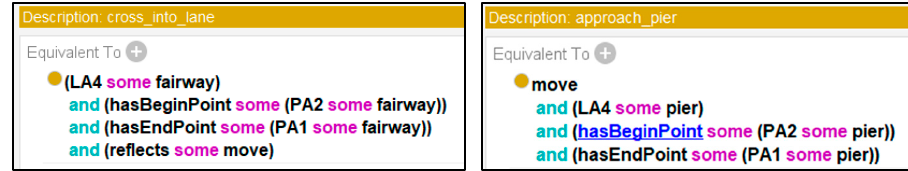
Figure 6. Knowledge representation of activity behaviors.